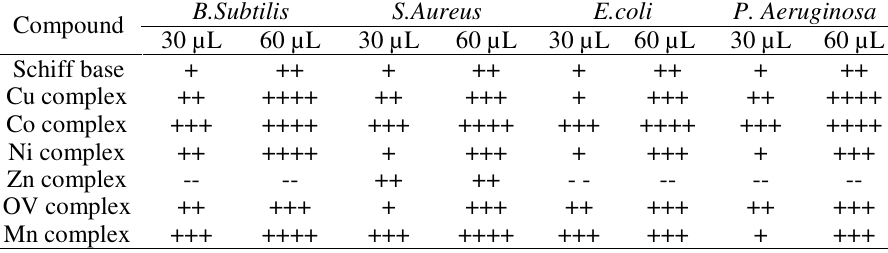
Table 5. Antibacterial activity data for Schiff base and its metal